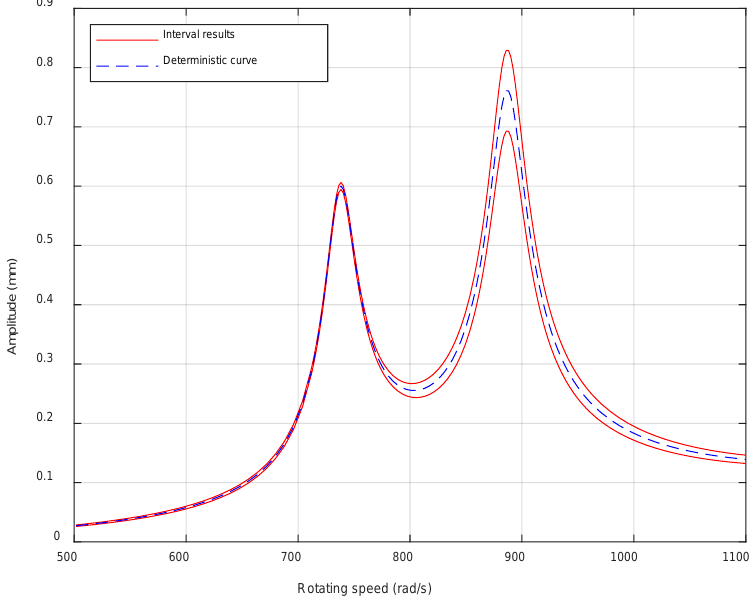
Figure 3. Dynamic response of the Lower Pressure (LP) rotor with uncertain imbalance on the LP rotor.